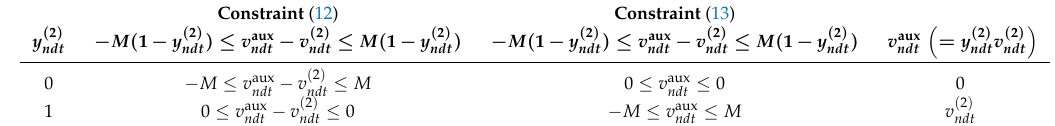
Table 2. Linearization of product y